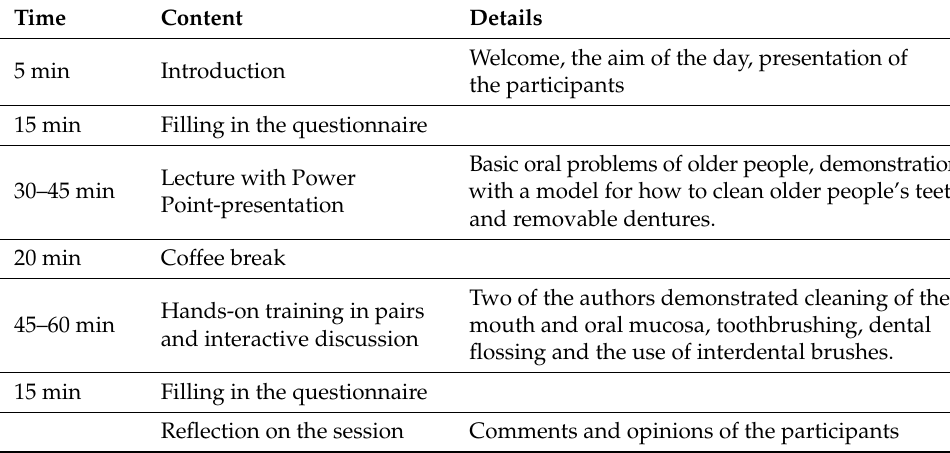
Table 1. Schedule of the